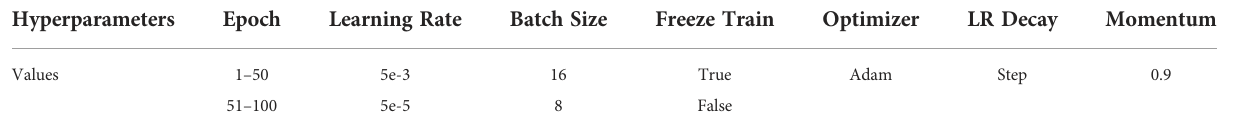
TABLE 3 Model hyperparameters at different training stages.